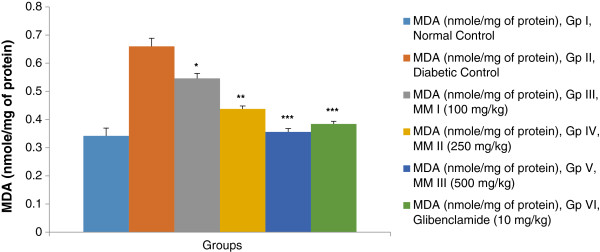
Effect of Melastoma malabathricum Linn. (MM) on level of Malondialdehyde (MDA) at different concentrations on STZ induced diabetic rats, compared to standard drug Glibenclamide; values are mean ± SEM; n = 6; *P < 0.05; **P < 0.01; ***P < 0.001; P > 0.05 is considered as non-significant (ns).